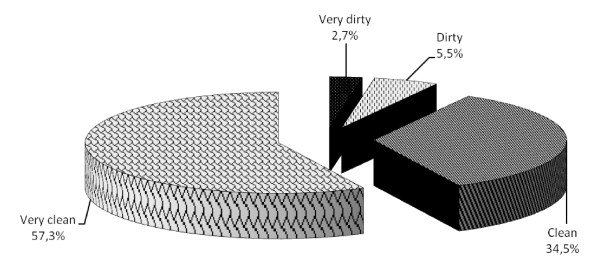
Level of cleanliness of the place where the body art was carried out.